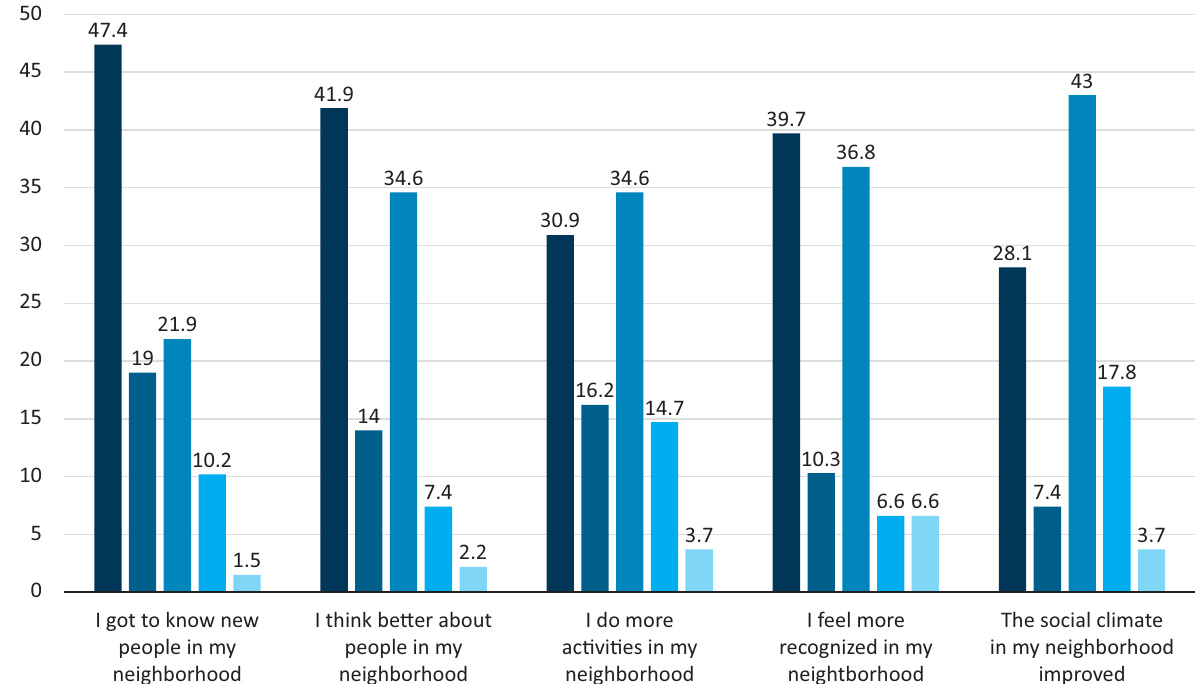
Figure 2. Metelen: By being in digital contact with my neighbors…. Note: Five‐point Likert scale—I strongly disagree, I dis‐ agree, neither/nor, I agree, and I strongly agree.